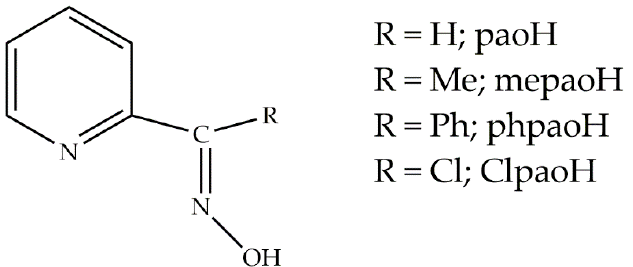
Figure 1. General structural formula of simple 2-pyridyl oximes, in which R is a non-donor group; the ligand used in the present work is methyl 2-pyridyl ketoxime (R = Me; mepaoH).